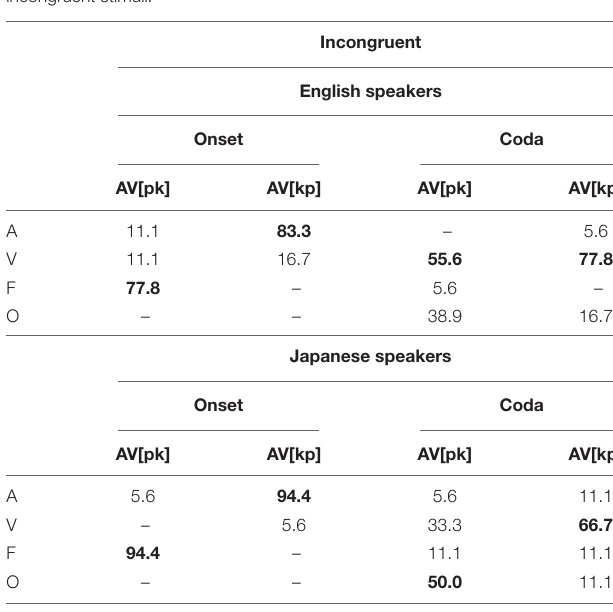
TABLE 7 | Proportion of responses in each category for fusible audio-visual incongruent stimuli.